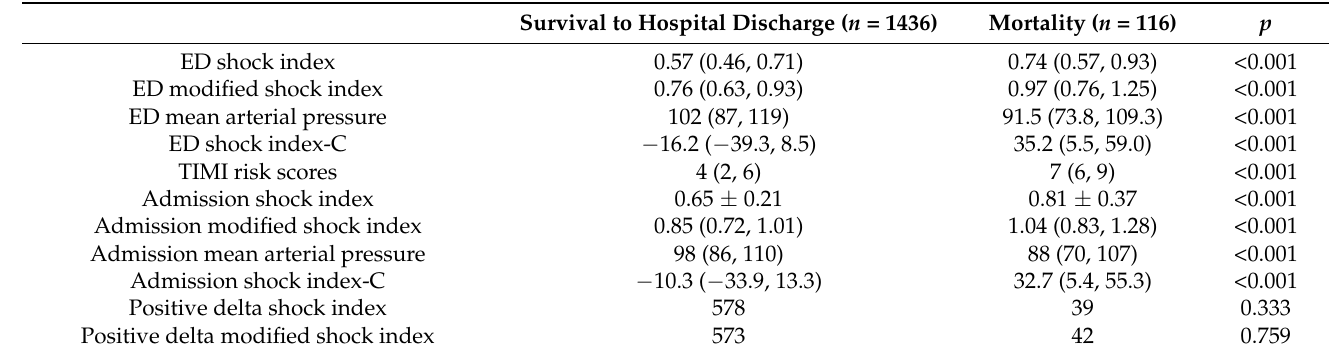
Table 2. Calculated SI, MSI, SIC, and TIMI risk scales at ED and hospital admission of STEMI patients receiving PCI.